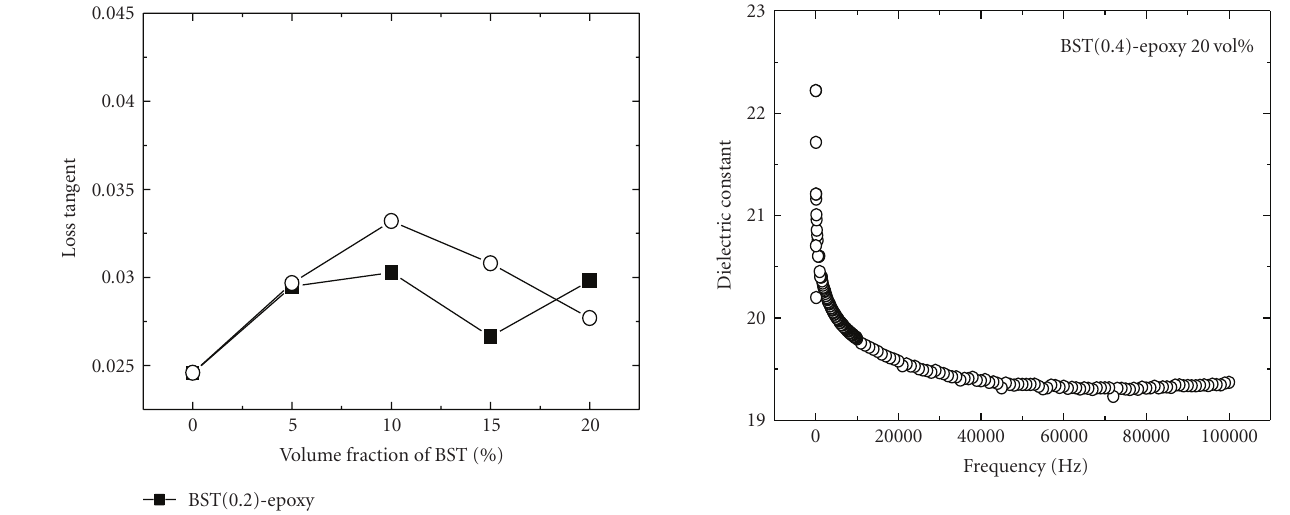
Figure 6: Dielectric constant of BST-epoxy sample with 20 vol% loading as a function of